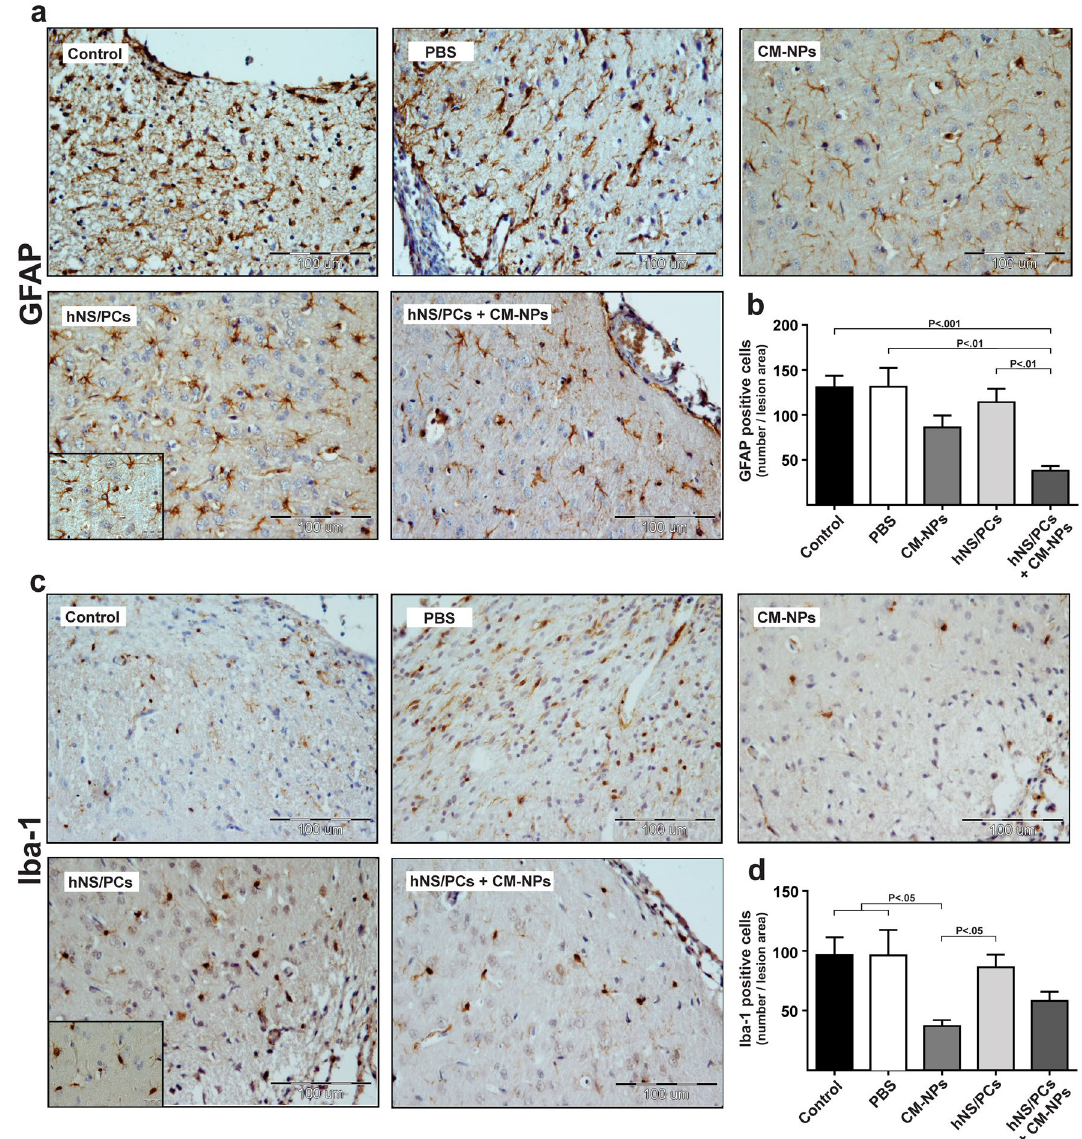
Figure 6. Immunohistochemistry staining of GFAP- and Iba-1-positive cells at the injury site after TBI and cell transplantation in rats. ( a ) GFAP-positive cells indicated brown stains are shown within the injury site after 28 days of TBI. ( b ) The mean number of GFAP-positive cells significantly decreased in the hNS/PCS + CM-NPs group compared to the control and PBS groups. Furthermore, the mean number of GFAP-positive cells in the hNS/PCS + CM-NPs group was significantly lower than the hNS/PCs group. ( c ) Immunohistochemistry slides of Iba-1-positive cells as indicated brown stain. ( d ) Bar graphs show the mean number of Iba-1-positive cells in the lesion area after 28 days of TBI in different study groups. The bar graphs indicate a significantly lower expression of Iba-1-positive cells in the CM-NPs group than in the control and PBS groups. Moreover, the mean numbers of Iba-1-positive cells in the CM-NPs group were significantly lower than that of the hNS/PCs group. Data are expressed as the mean ± SEM (n =